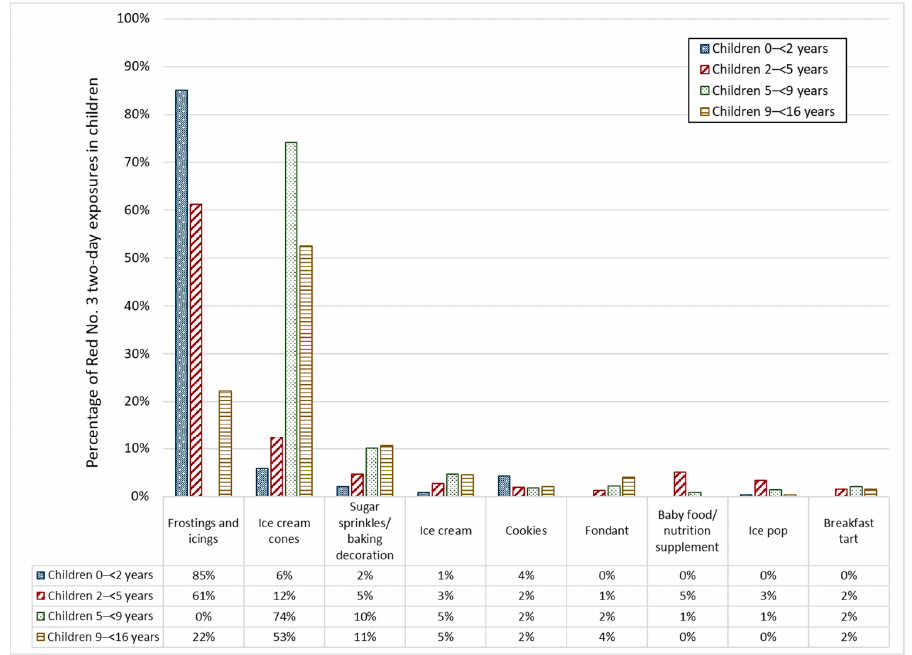
Figure 2. Top foods contributing to FD&C Red No. 3 two-day average exposure estimates in chil- dren aged 0–<16 years (typical-exposure scenario) who consumed at least one food containing Red No.